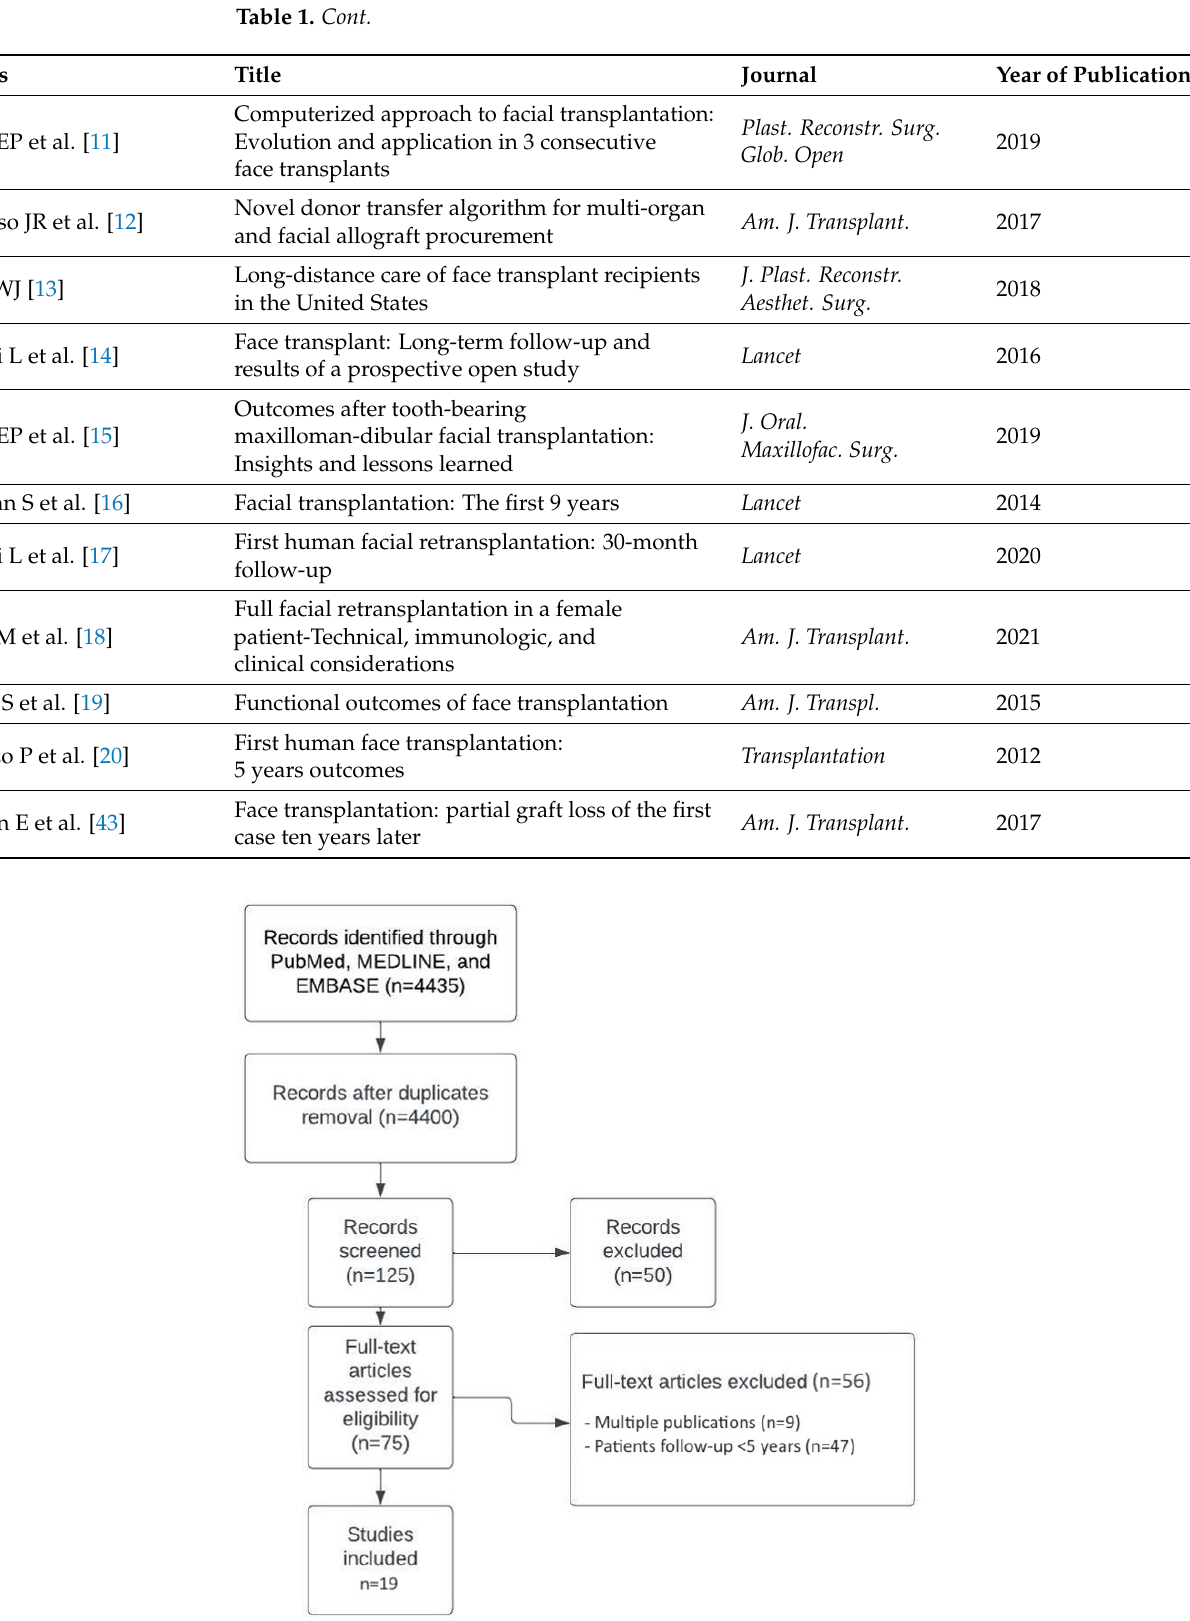
Figure 1. This diagram shows the flow of information through the different phases of this review.